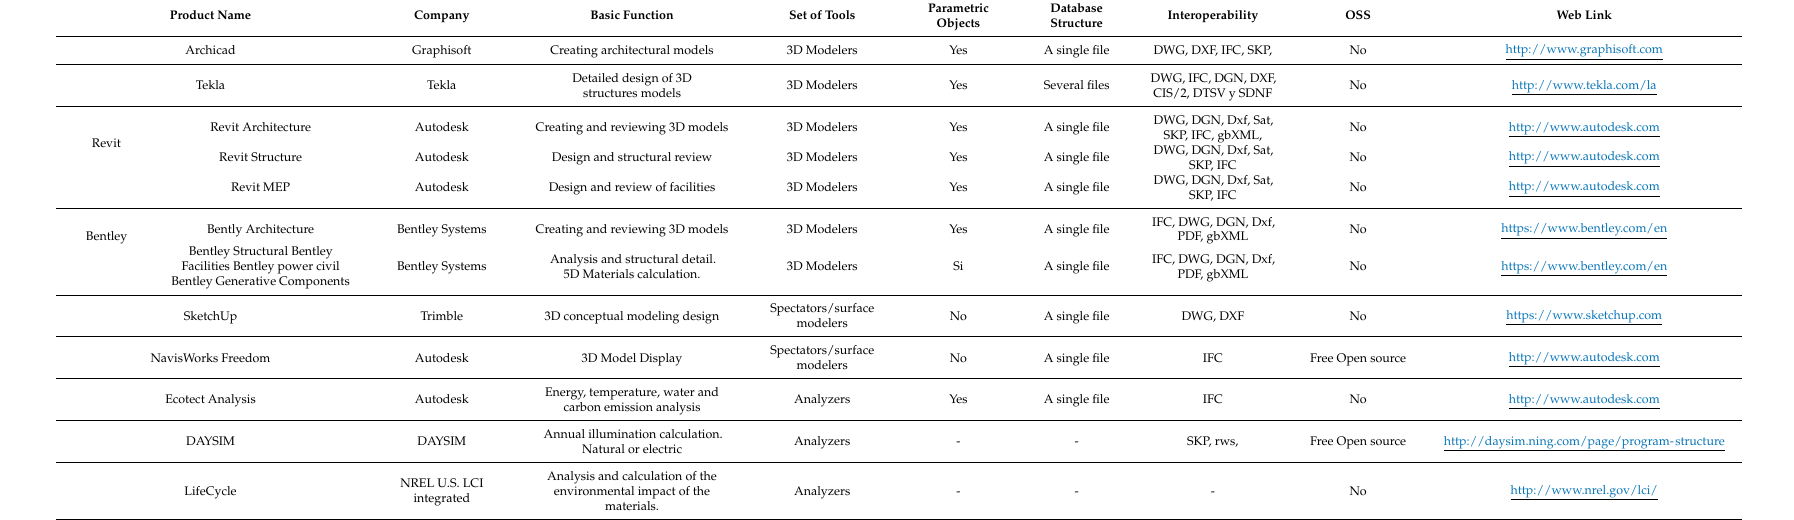
Table 2. Most used platforms in the Architecture, Engineering, and Construction (AEC)